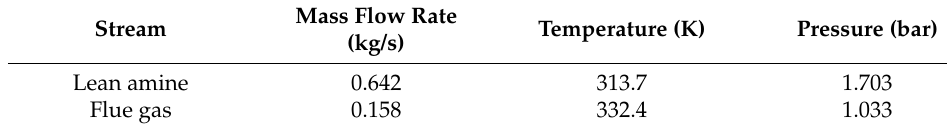
Table 1. Parameters in base case.